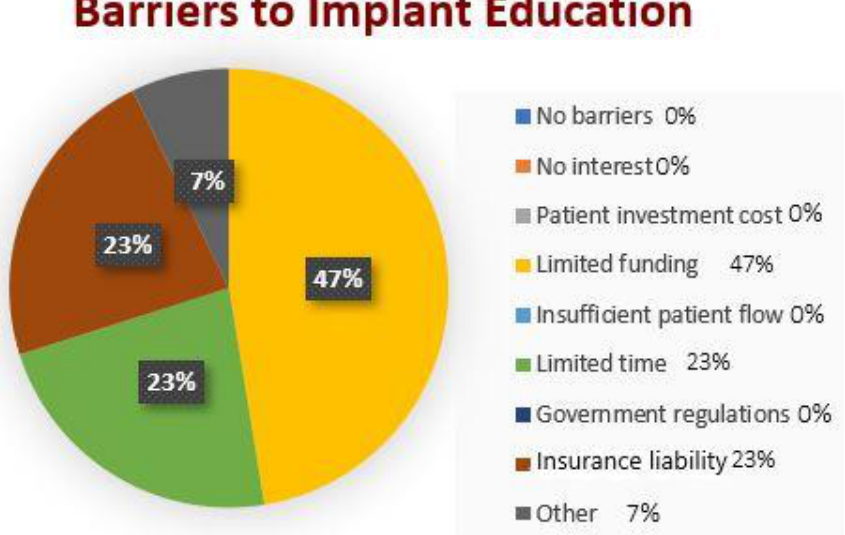
Figure 3. Barriers to undergraduate dental implantology education across the UK.